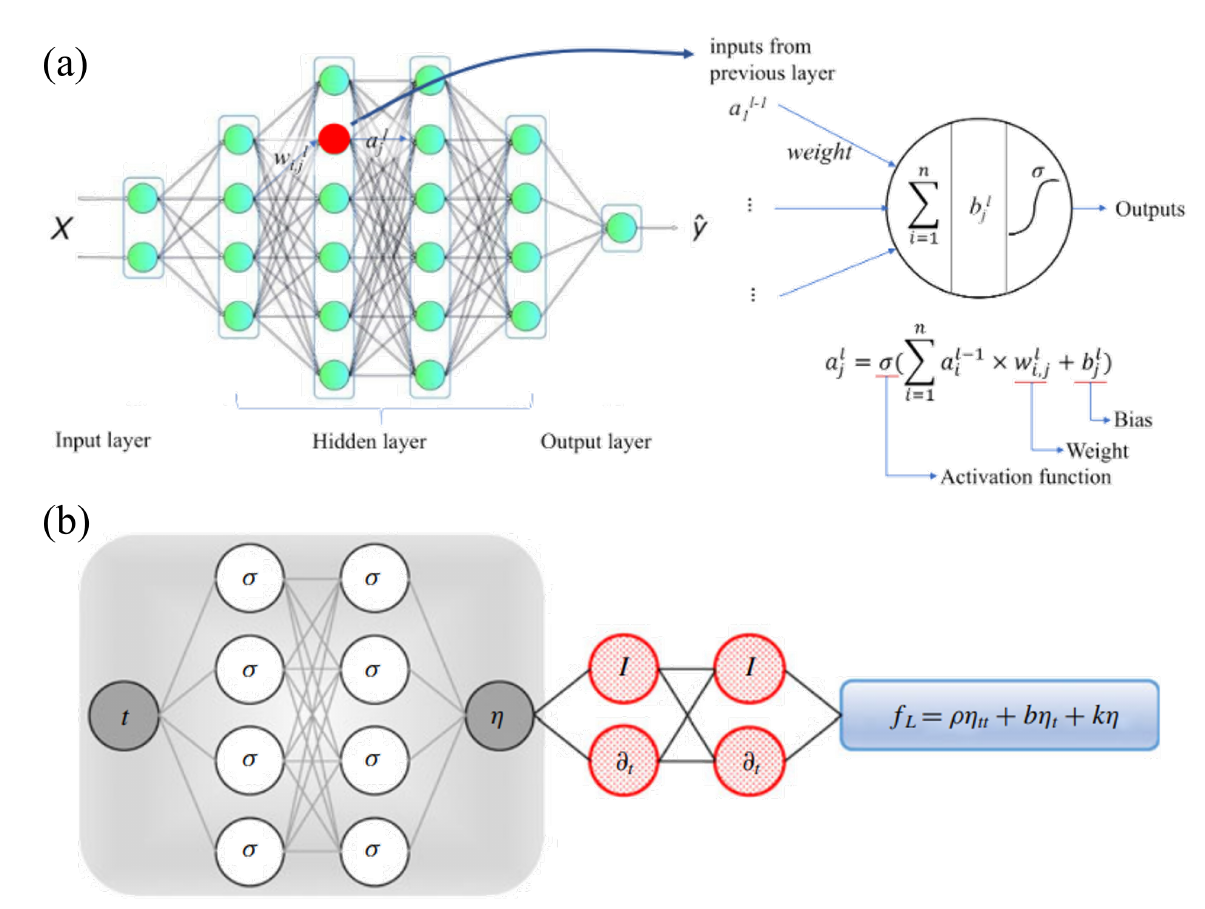
Figure 10. The architecture of a deep neural network (DNN). ( a ) A general deep neural network consisting of a number of computational units (neurons) organized into a number of layers and connected in a graph structure [187]. In this example, the neural network of an input layer having two neurons (viz., input X is a two-dimensional vector), an output layer with one neuron (giving a prediction of the output ˆ y ) and four hidden layers that pass information from a previous layer into the next layer. ( b ) A physics-informed neural network (PINN) with an input t , an output η , and two hidden layers with four neurons each